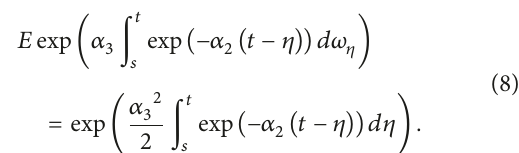
Figure 2: Real data versus SDE Gompertz versus Trend Gompertz in the United